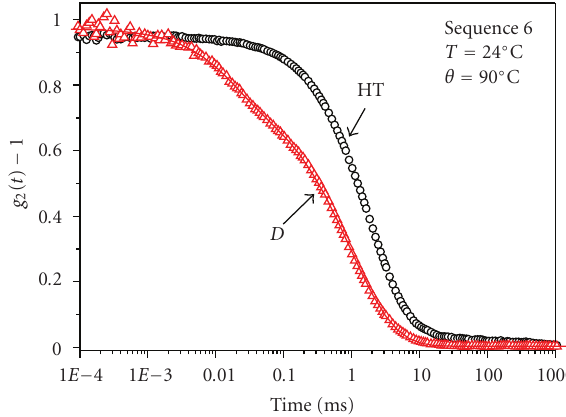
Figure 2: Typical DLS autocorrelation functions detected for heat treated (HT) and dialysed (D) samples. The slow di ff usive mode (correlation time in the range of 1–10 ms at θ = 90 ◦ ) is observed for both samples, while the fast di ff usive mode (correlation time in the range of 0.01–0.1 ms at θ = 90 ◦ ) is observed only for the dialysed sample. The fast mode is assigned to quadruplex motion, while the slow mode presumably arises from dynamics of loose polyion